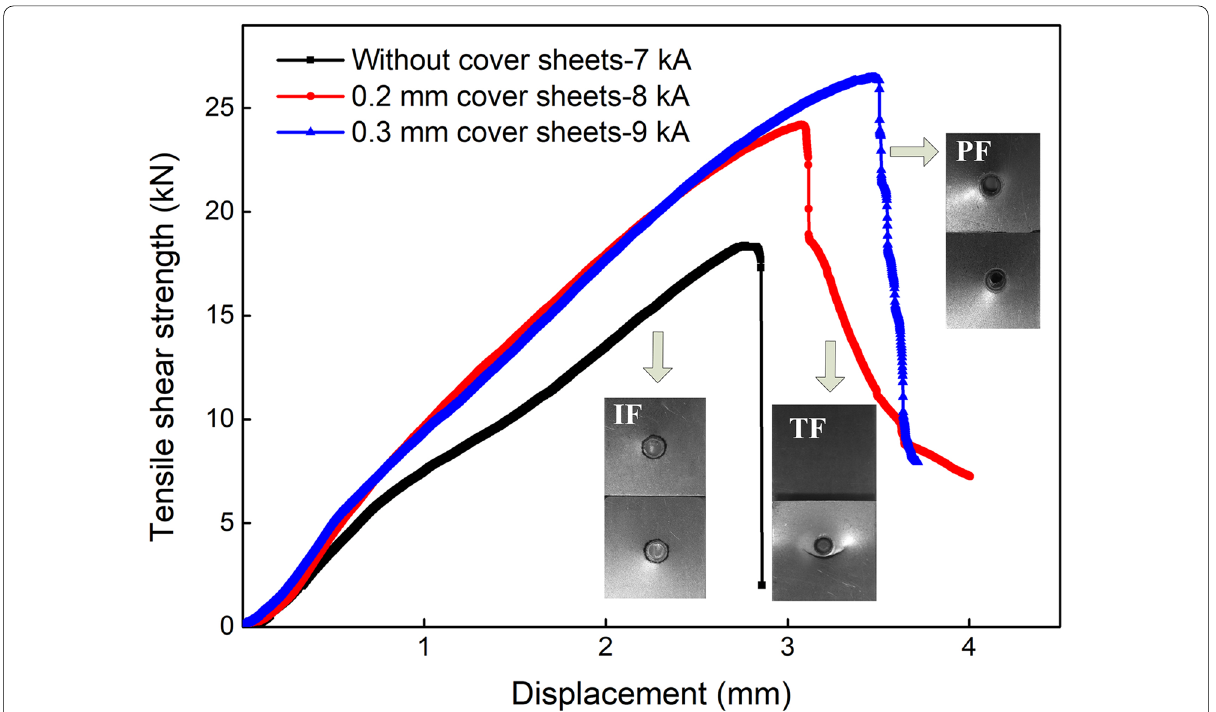
Figure 3 Typical tensile shear curves of joints with and without cover sheets under critical welding